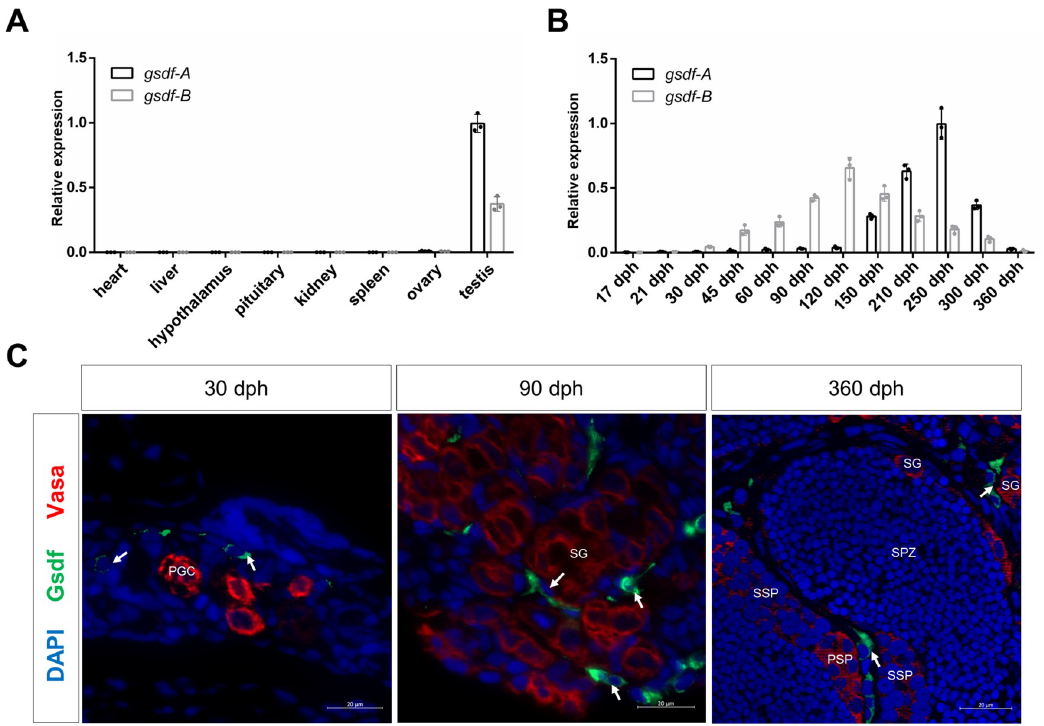
Fig 2. Expression characterization of gsdf-A and gsdf-B . (A-B) Relative real-time quantitative PCR (qPCR) of gsdf-A / gsdf-B transcripts in adult organs (A) and male gonads at different developmental stages (B) . (C) Immunofluorescence co-localization of Gsdf and Vasa in male gonads at 30, 90, and 360 dph (days post hatching). Green and red fluorescence were immunostained by anti-Gsdf antibody and anti-Vasa antibody, respectively, and blue fluorescence was stained by DAPI. PGC: primordial germ cell; SG: spermatogonium; PSP: primary spermatocyte; SSP: secondary spermatocyte; SPZ: spermatozoa. Arrows indicate somatic cells.